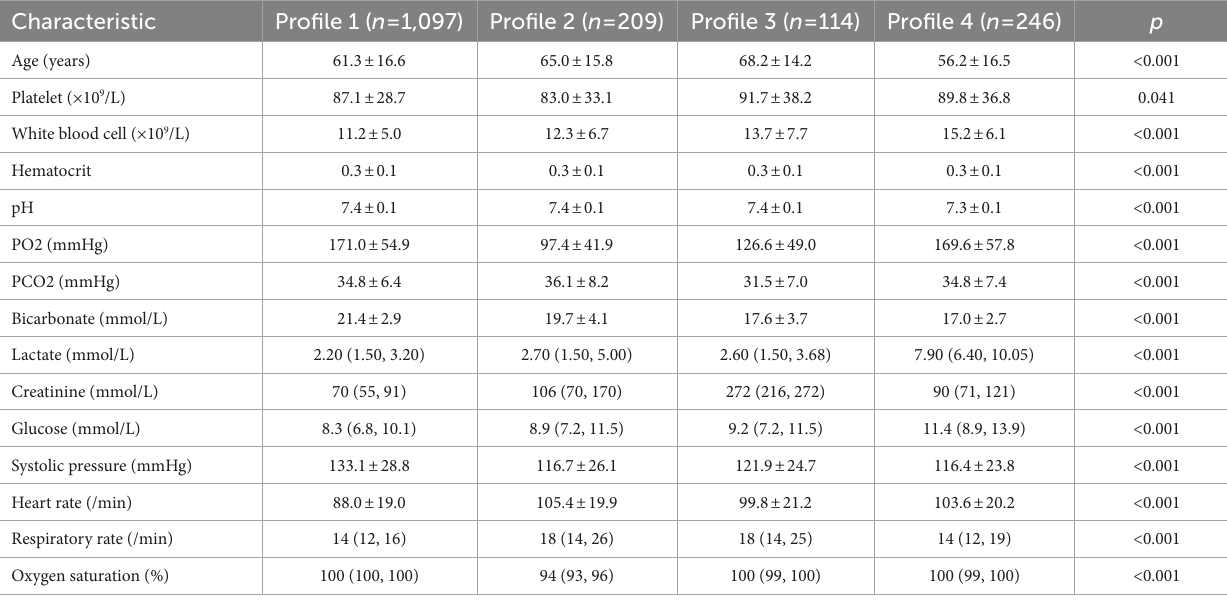
TABLE 1 Continuous variables included in the mixture